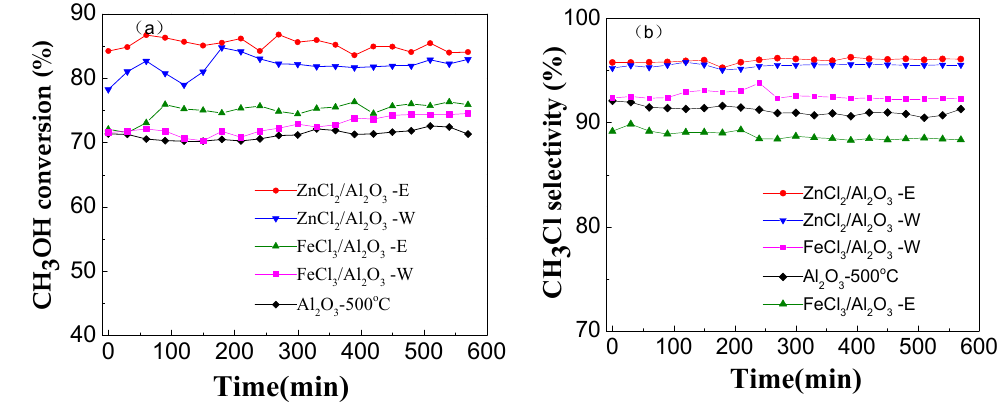
Figure 5. The methanol conversion ( a ) and the methyl chloride selectivity ( b ) over modified mesoporous alumina (Conditions: 4.75 g MeOH ∙ g − 1 (cat.) ∙ h − 1 , temperature 280 °C).